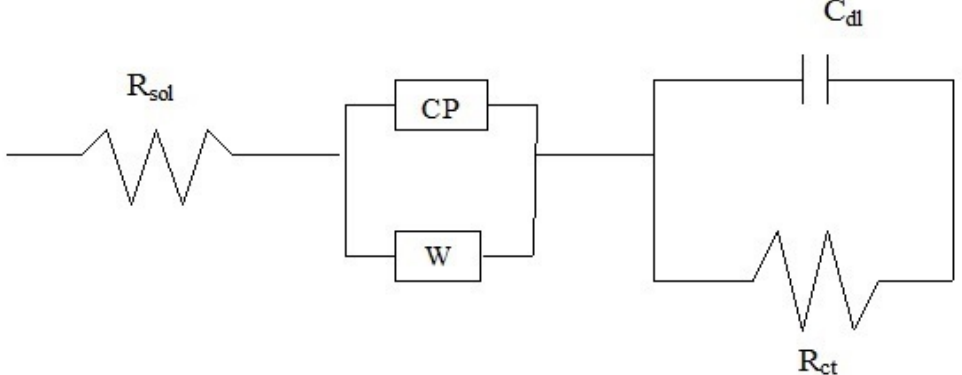
Figure 10. Equivalent circuit depicting the corrosion of coatings 2hcd and 3ushcd.